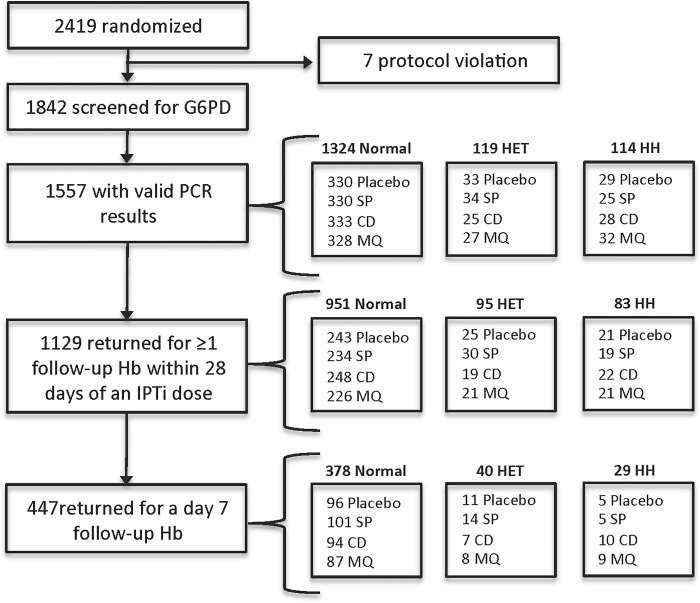
Trial profile for the entire cohort (both sites combined).SP = sulfadoxine-pyrimethamine. CD = chlorproguanil-dapsone. MQ = mefloquine. HET = heterozygous. HH = homo-/hemizygous.